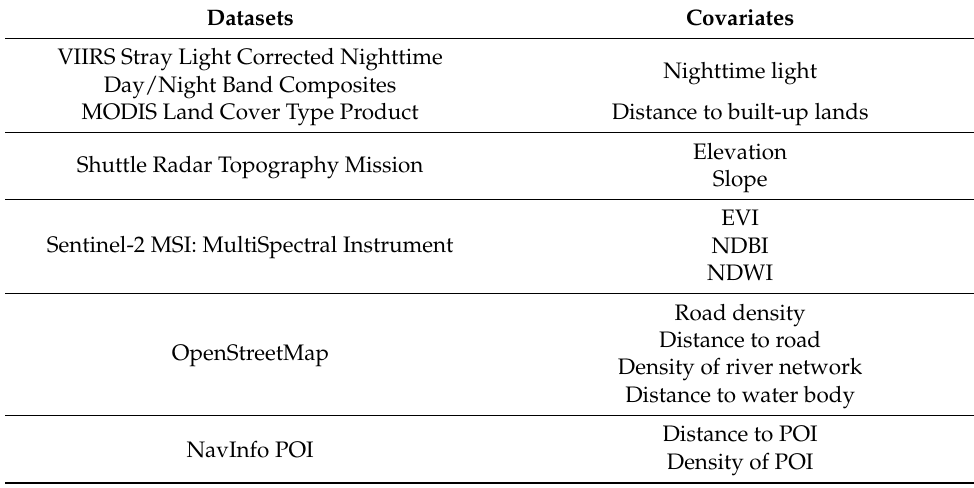
Table 2. Covariates used in dasymetric